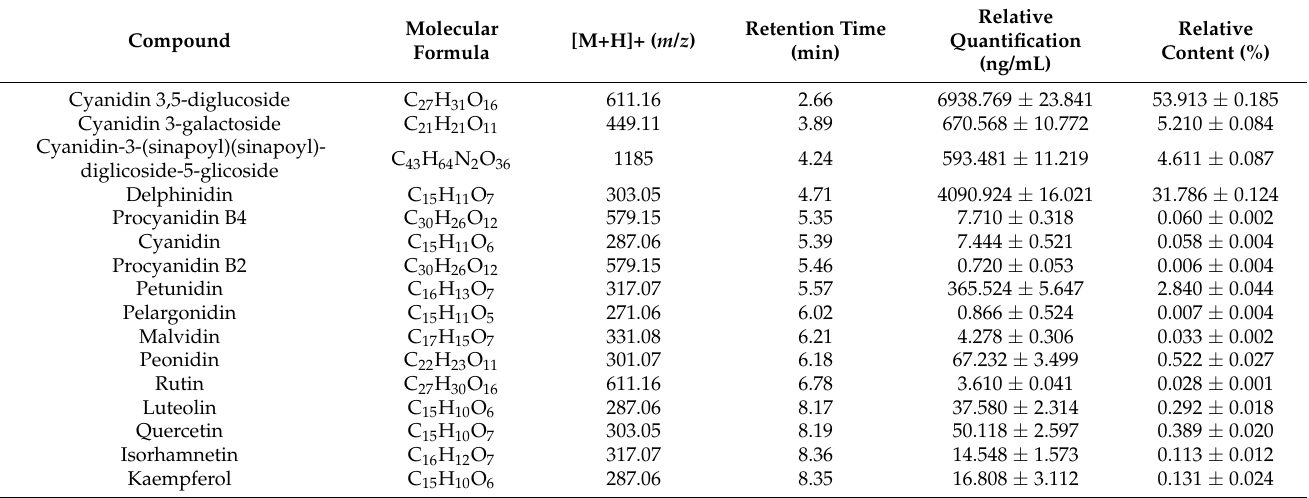
Table 1. Characteristics of anthocyanins found in RCAE with their relative amounts.